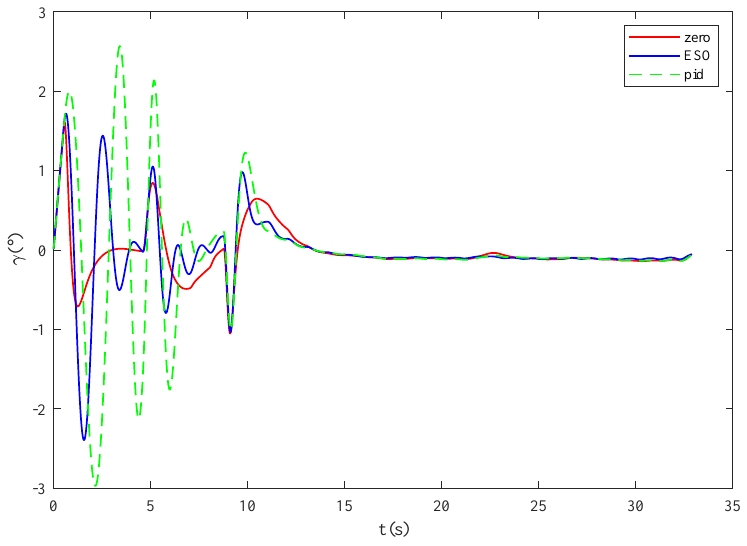
Figure 15. Comparison of roll angle response curves between PID and the